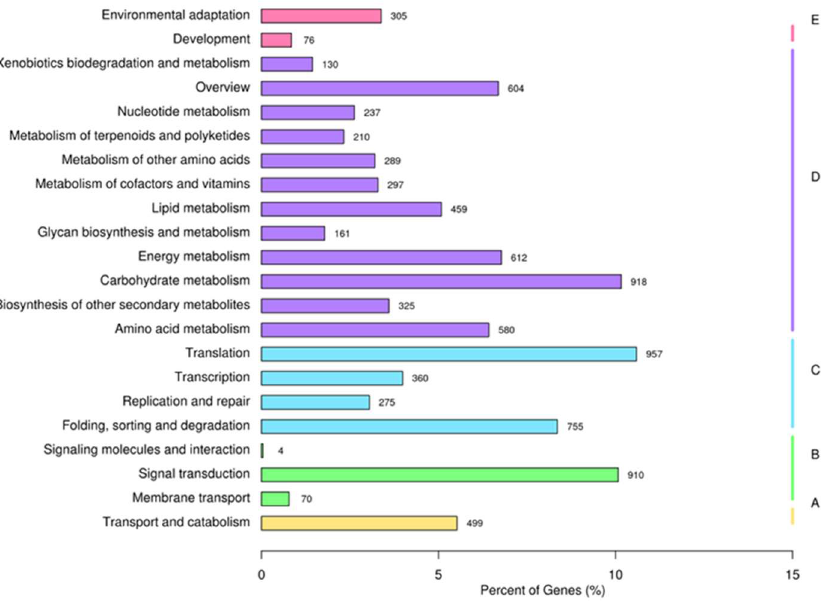
Figure 4. KEGG metabolic pathways of assembled unigenes of the L. yunnanensis flower transcriptome: ( A ) cellular processes; ( B ) environmental information processing; ( C ) genetic information processing; ( D ) metabolism; ( E ) organismal systems. The x -axis indicates the number of genes in each metabolic pathway and the ratios of the number of genes to total number of annotated genes; the y -axis indicates the names of the KEGG metabolic pathways.